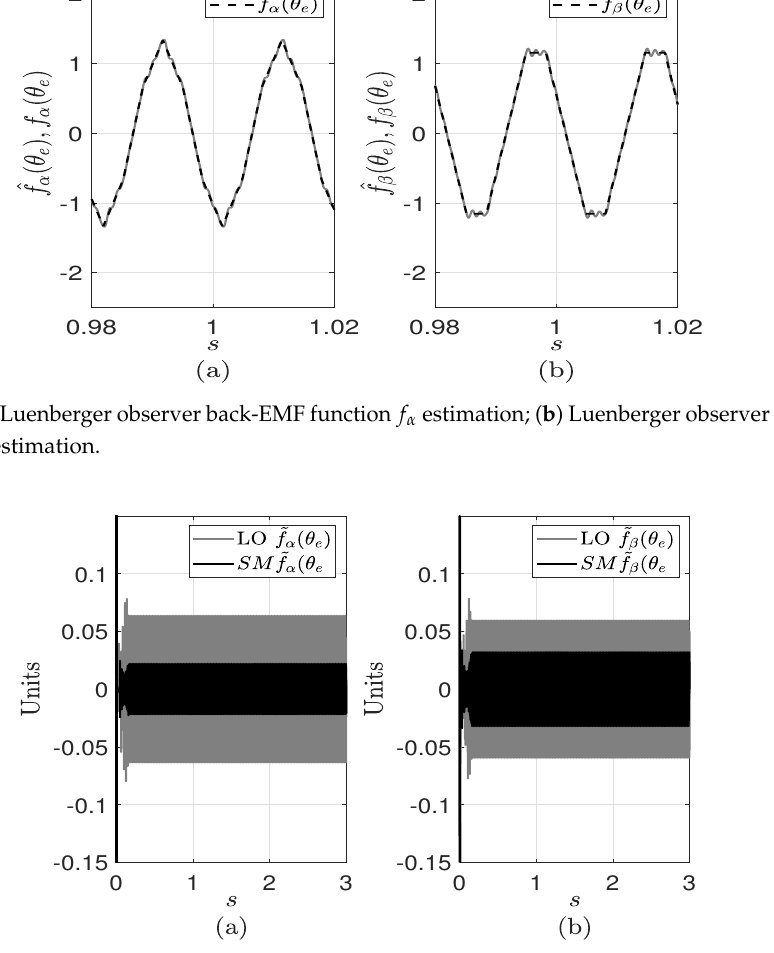
Figure 9. ( a ) Comparison of Luenberger and sliding mode based observer f α estimation error; ( b ) Comparison of Luenberger and sliding mode based observer f β estimation